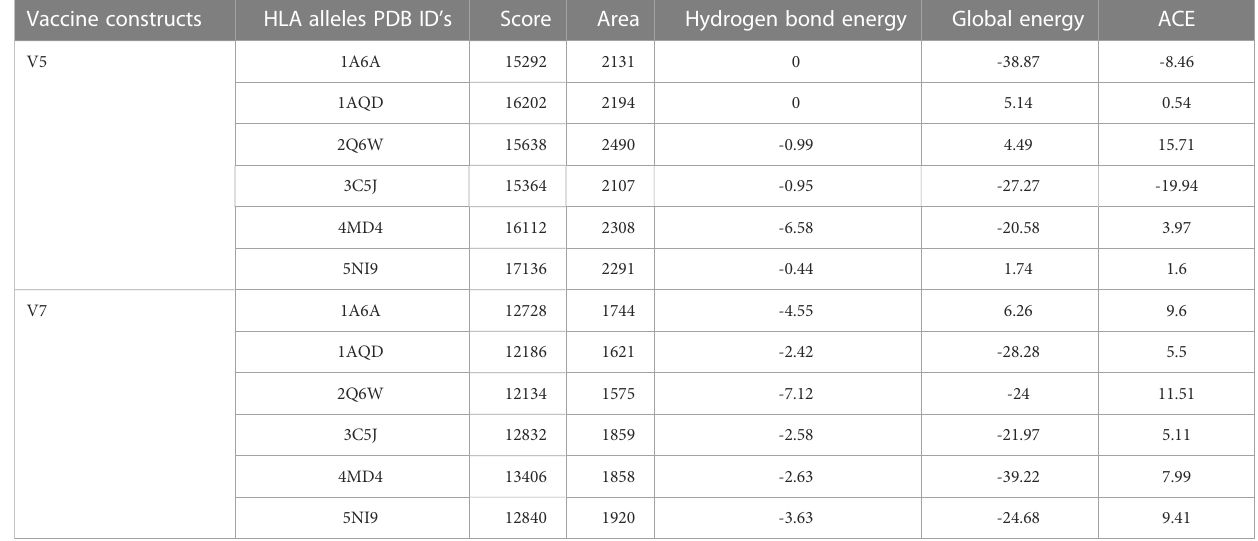
TABLE 4 Docking analysis of prioritized vaccine constructs (V5 and V7) with different HLA alleles. Vaccine